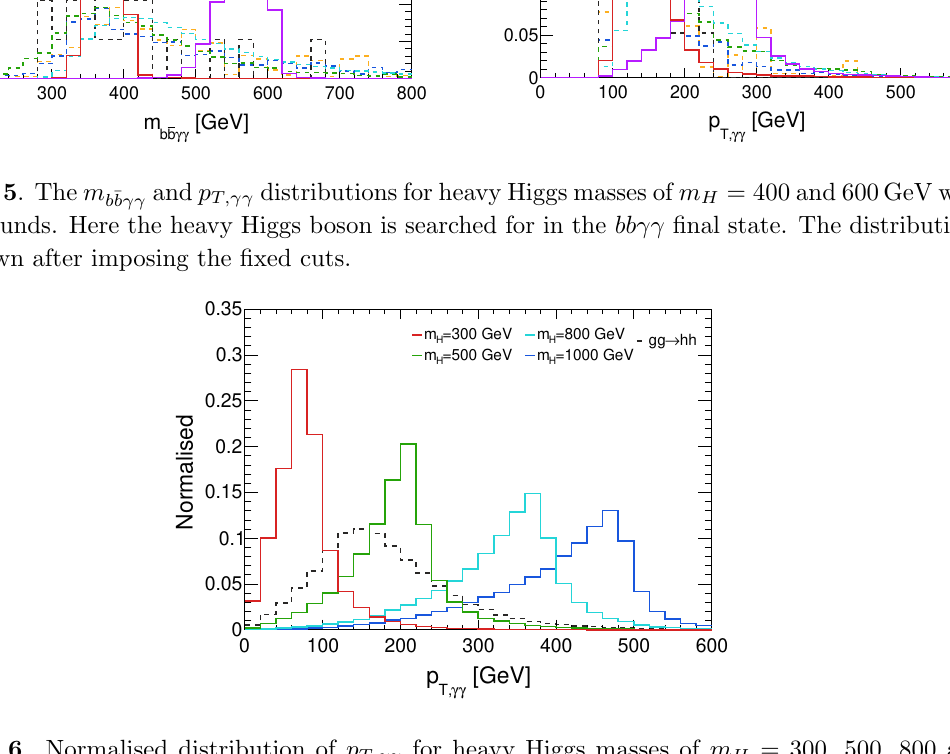
Figure 6 . Normalised distribution of p T;(cid:13)(cid:13) for heavy Higgs masses of m H = 300, 500, 800 and 1000 GeV along with the SM di-Higgs production from gluon-gluon fusion